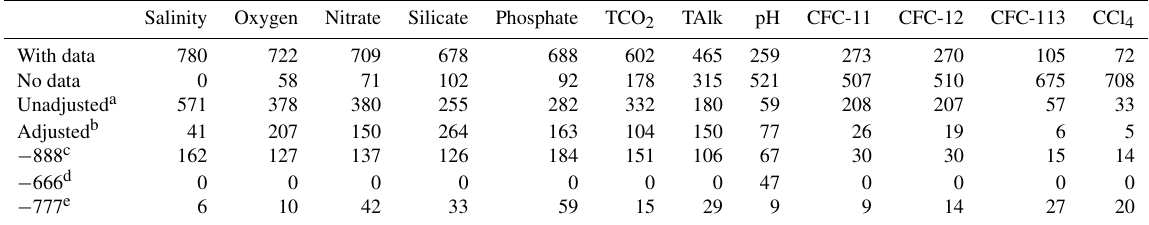
Figure 3. Size distribution of applied adjustments for each core variable that received secondary QC. Gray areas depict the initial minimum adjustment limit. Entries for which data could not be secondary quality-controlled or were considered of insufficient quality for our product are excluded from this figure. Table 6. Summary of secondary QC actions per variable for the 780 non-dismissed